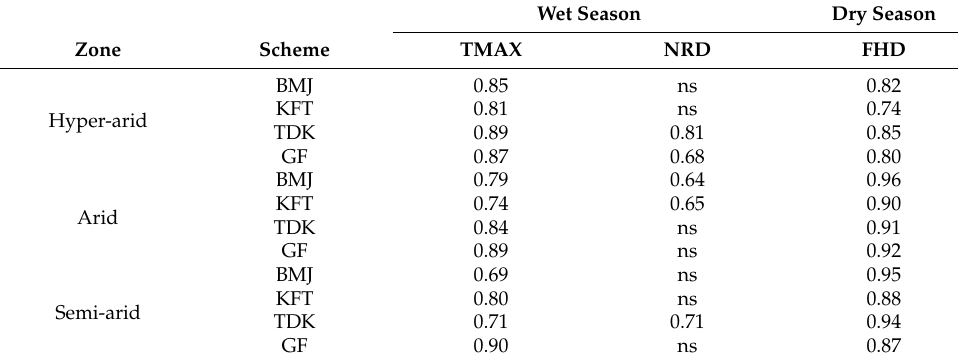
Figure 4. Normalized Taylor diagrams (obs: normalized standard deviation of observations) for monthly and seasonal rainfall during the wet season (June–September) in the hyper-arid, arid, and semi-arid zones of Sudan. BMJ, KFT, TDK, and GF are the Betts–Miller–Janjic, improved Kain–Fritch, modified Tiedtke, and Grell–Freitas schemes, respectively. ( a ) June. ( b ) July. ( c ) August. ( d ) September. ( e ) June–September. Table 2. The Pearson correlation coefficient ( R ) for seasonal maximum temperature (TMAX) and the number of rainy days (NRD) (daily rainfall ≥ 1 mm) in the wet season (June–September), and the frequency of hot days (FHD) (daily TMAX > 35 °C) in the dry season (November–February). All correlation coefficients are significant at p ≤ 0.05, and ns denotes no significance.